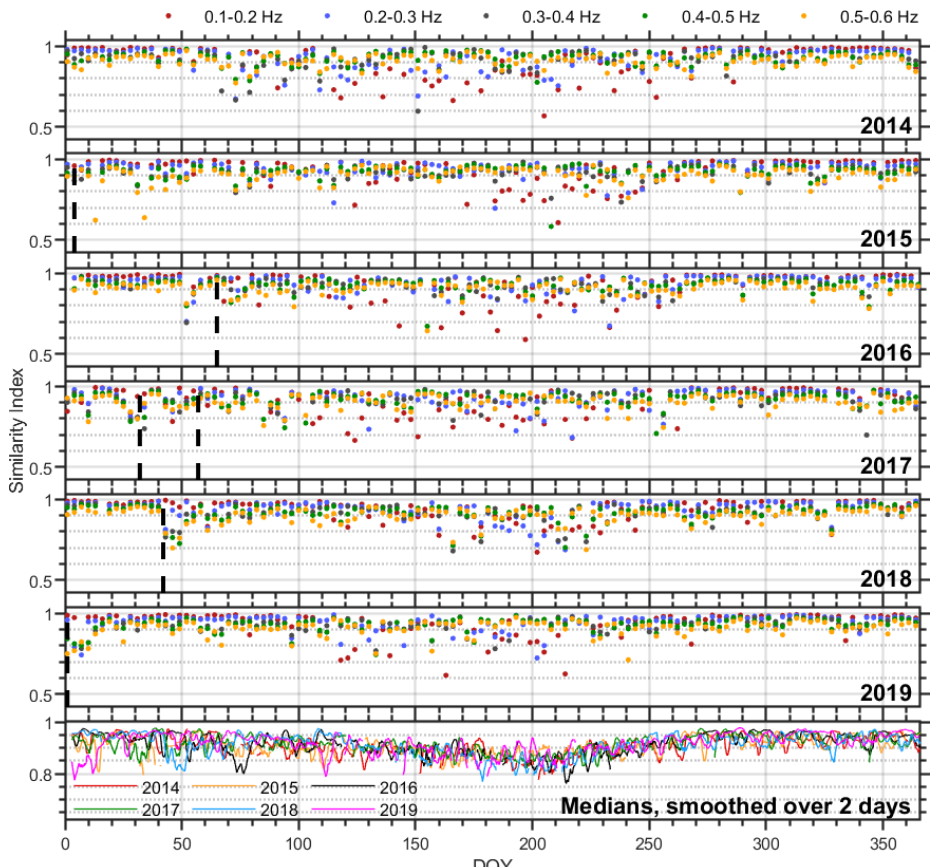
Figure 5. Multi-year comparison between vespagrams and smoothed modeled microbarom soundscapes at the IS37 station. The similarity index is color-coded, depending on the frequency band, as follows: 0.1–0.2Hz – red; 0.2–0.3Hz – blue; 0.3–0.4Hz – gray; 0.4–0.5Hz – green; 0.5–0.6Hz – orange. Data are presented as a discrete set with a time step of 3d (day 1 – 00:00UTC, day 4 – 00:00UTC, etc.). Black dashed lines present SSW onsets. Medians over frequency bands in the last panel are color-coded, depending on the year, as follows: 2014 – red; 2015 – orange; 2016 – black; 2017 – green; 2018 – blue; 2019 –